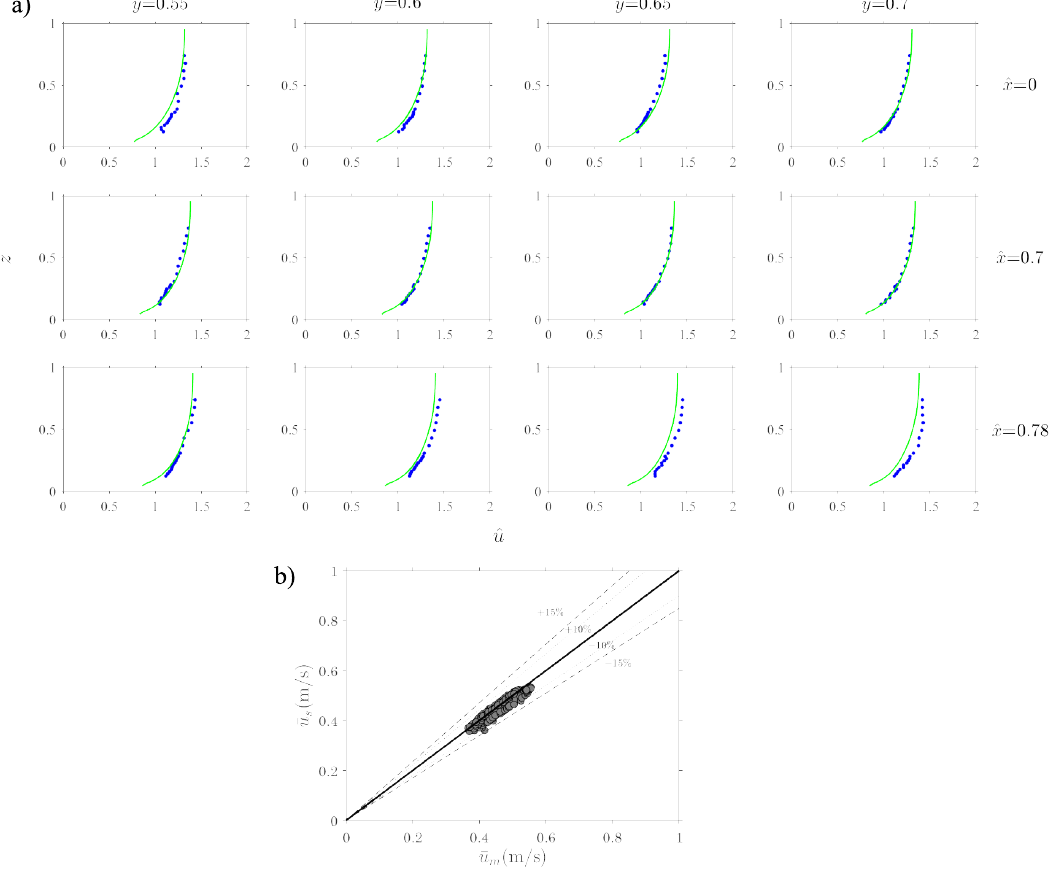
Figure 9. ( a ) comparison of measured (blue dots) and simulated (green lines) non-dimensional streamwise velocity component profiles in cross-sections Nos. 1, 2 and 3 along four longitudinal profiles; ( b ) comparison of measured and simulated streamwise velocity components.